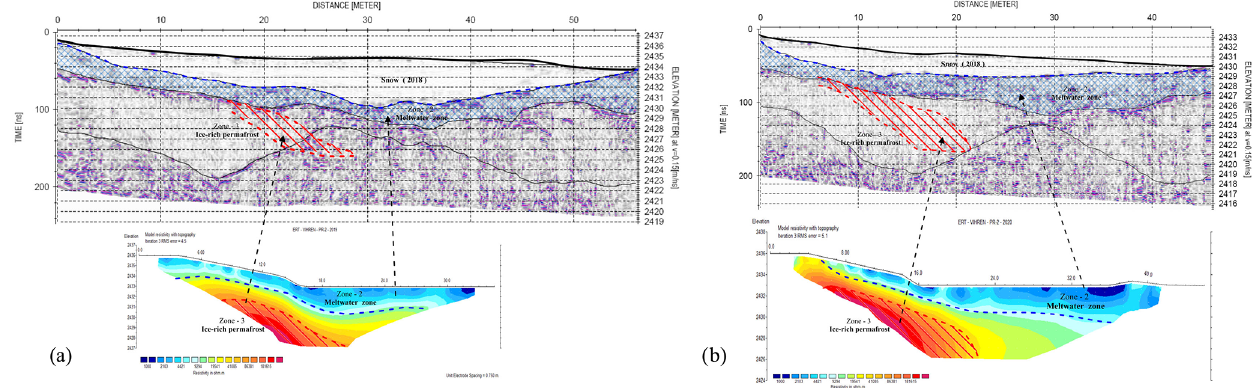
Figure 9. Aligned profiles ERT(2019)-2, ERT(2020)-2, GPR(2018)-1, and GPR(2018)-2. The red-shaded zones have the same size on ERT and GPR profiles to show areas of overlap for the permafrost zone. Blue-shaded areas present the layer draining the